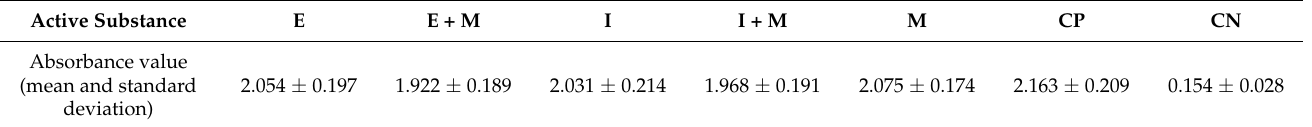
Table 2. Values of A. actinomycetemcomitans for the wells not submitted to adjuvant therapy.